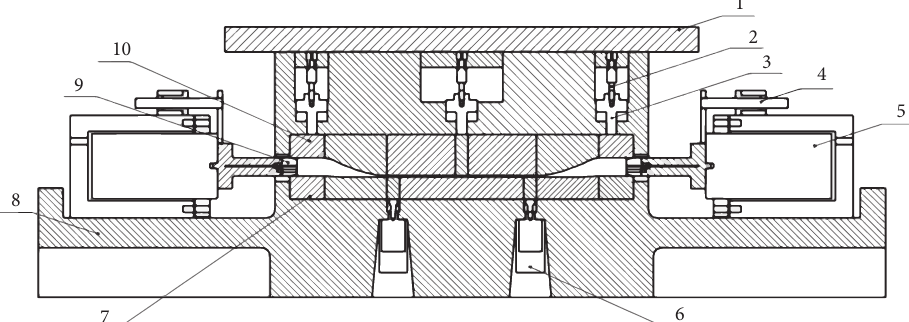
Figure 3: General assembly diagram of hydraulic expansion die for torsion beam: (1) upper die base; (2) cylinder; (3) pull-out rod of upper die; (4) displacement sensor; (5) hydraulic cylinder; (6) ejection cylinder; (7) matrix; (8) lower die base; (9) sealing plug; (10)